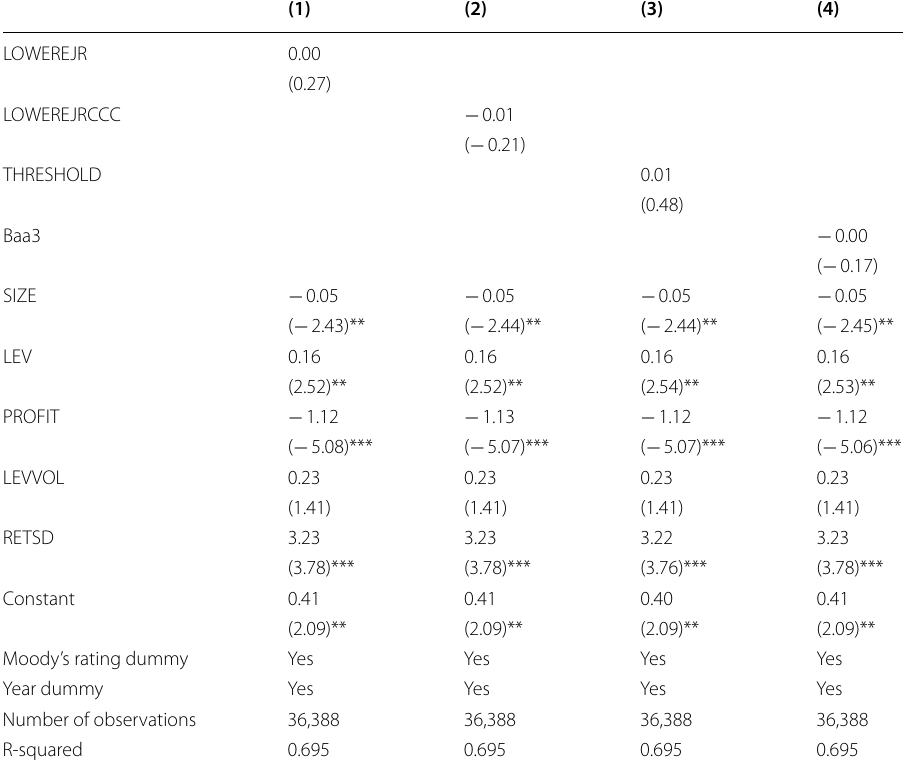
Table 6 Rating difference between Moody’s and EJR and default